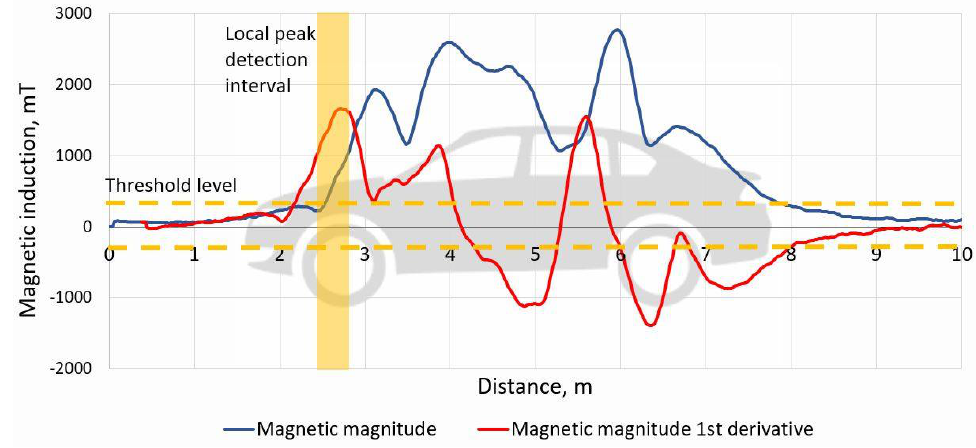
Figure 8. An example of vehicle magnetic magnitude and its 1st derivative signals. According to the above explained algorithm, the time-based signature is converted to a distance-based signal. Peak detection algorithm is employed to locate the very first and the last significant peaks above the threshold level.